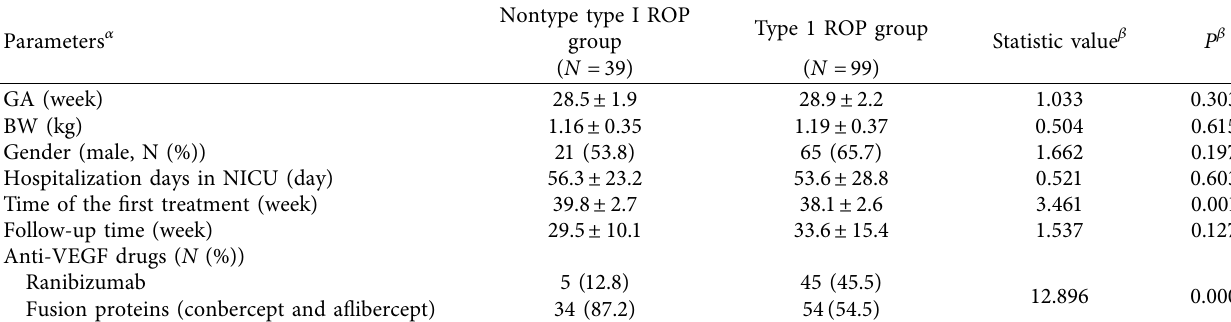
Table 1: Characteristics of subjects with type 1 and nontype 1 ROP ( N �